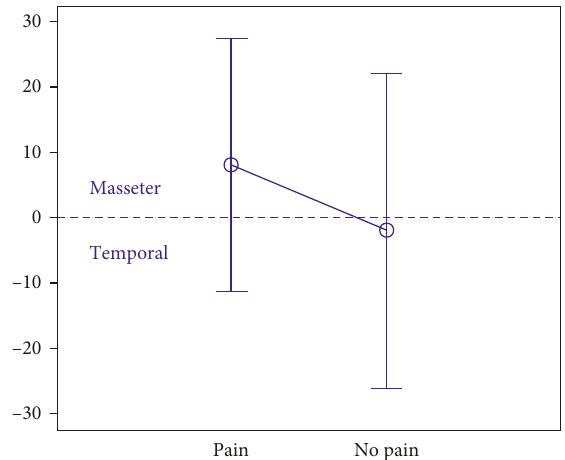
Figure 8: Activity index during swallowing in group of TMD